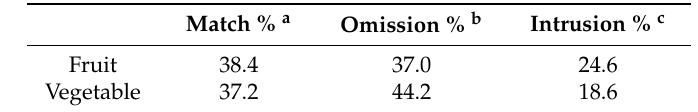
Table 3. Match, omission and intrusion rates of types of fruits and vegetables reported in the FWQ vs. 24hDR ( n =